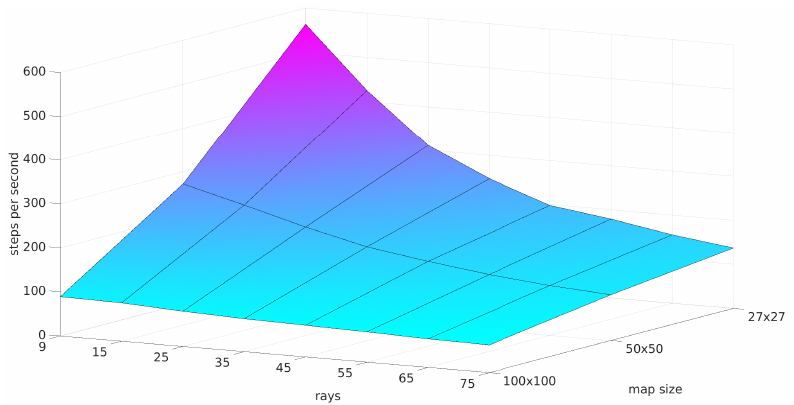
Figure 5. A graphical visualization of the simulator speed depending on the map size and on the number of rays. A sensor range of 11 was chosen with a number of steps per voxel of u =